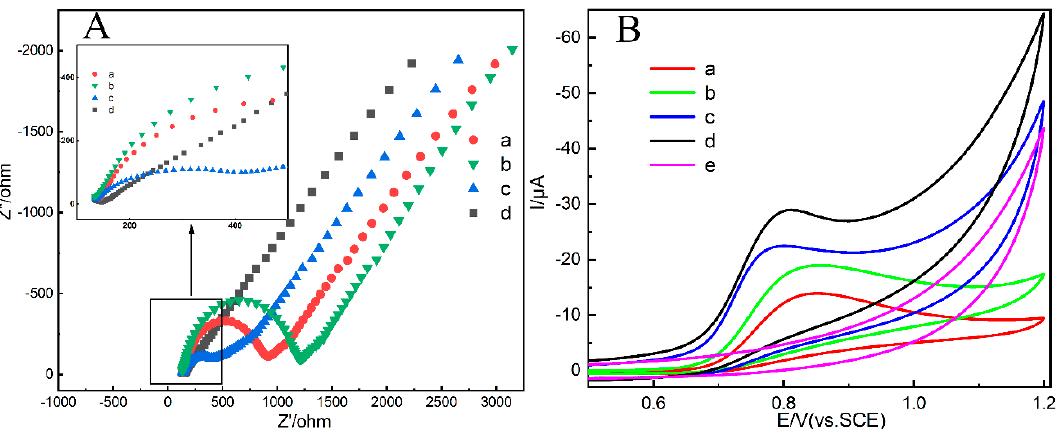
Figure 4. Nyquist plots ( A ) in K 3 [Fe(CN) 6 ] solution and CV curves ( B ) of different modified electrodes: (a) bare GCE, (b) MoS 2 /GCE, (c) MWCNT-COOH/GCE, and (d) MoS 2 /MWCNT-COOH/GCE in 0.1 M PBS with 500 µ M nitrite (e) MoS 2 /MWCNT-COOH/GCE in 0.1 M PBS without